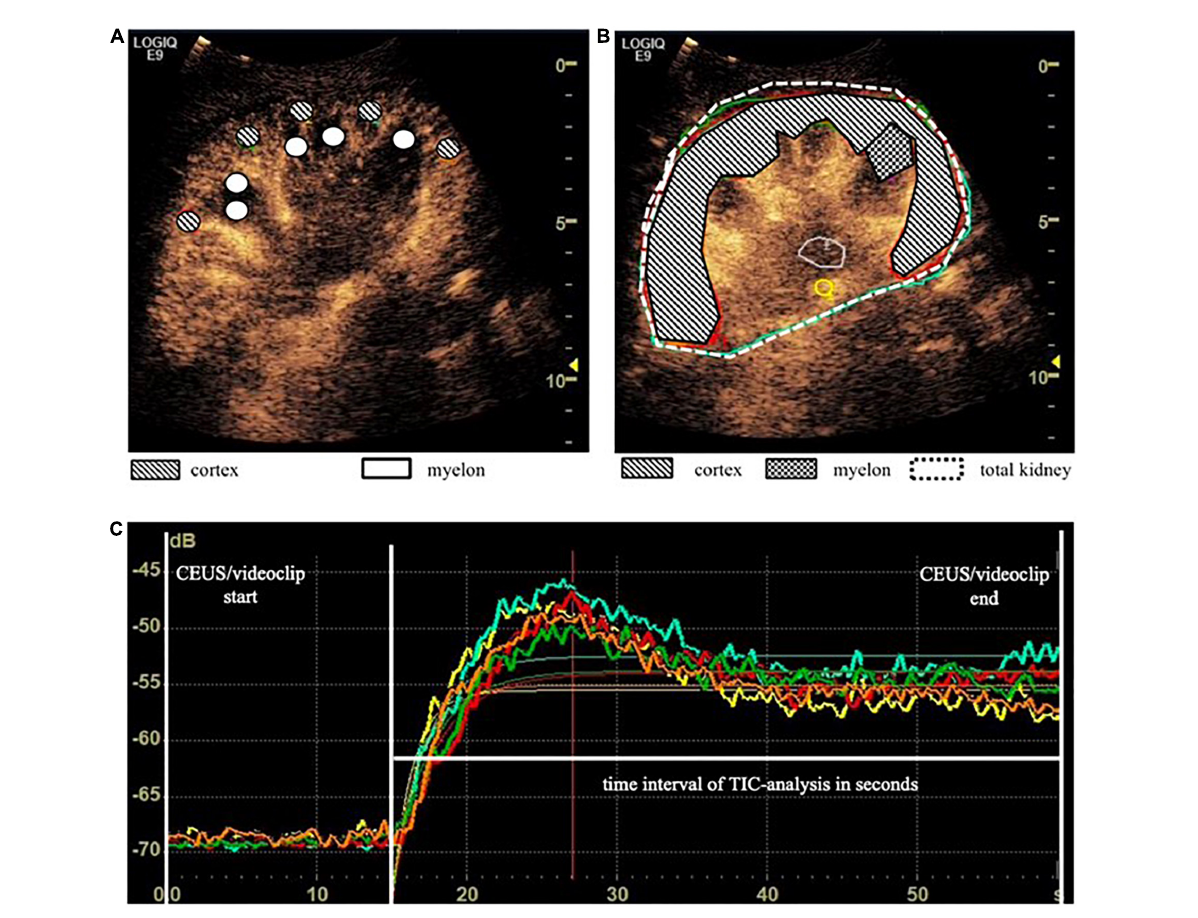
FIGURE1 Time-intensity curve analysis (TIC analysis) was calculated based on different region of interest (ROI) methods. (A) ROI 5 and ROI 10 consisted of 3 to 5 × 5 mm 2 and 10 mm 2 placed in the cortex and myelon. TIC parameters of ROI 5 / 10 were calculated as averages of the multiple ROIs. (B) ROI Anat was an anatomical outline of the total kidney, the whole cortex, the upper and the lower cortex, and one representative myelon. (C) TIC curves based on ROI 5 in the cortex.